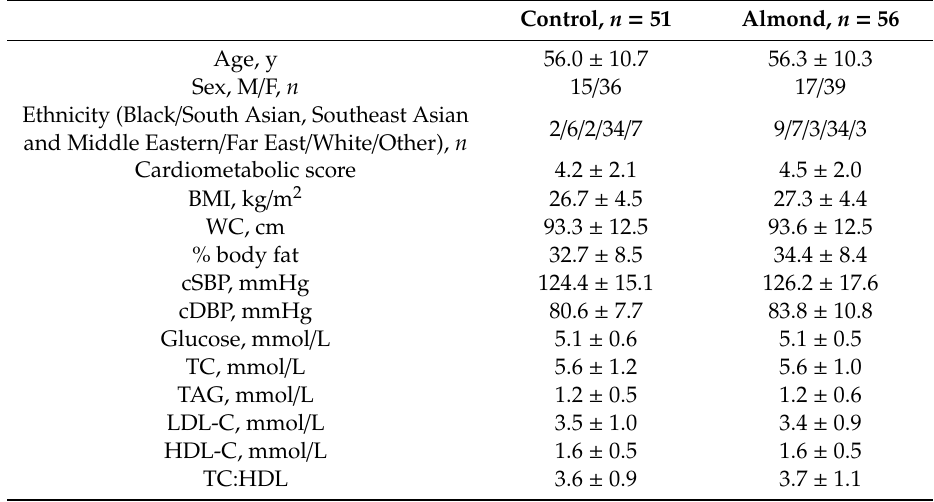
Table 1. Subject characteristics at screening for those randomized to treatment (mean ±